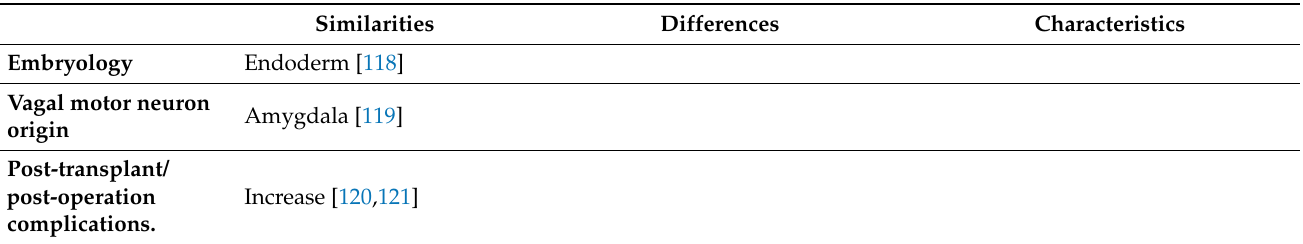
Table 2. Comparisons between fatty liver and fatty